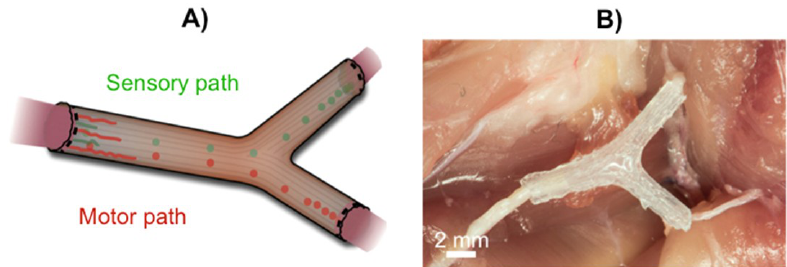
Figure 2. ( A ) Schematic of implanted nerve guide showing bifurcation into sensory and motor nerve paths. ( B ) Photograph of an implanted 3D printed nerve guide prior to suturing. Adapted with permission from ref. [31]. Copyright 2015, Wiley-VCH.